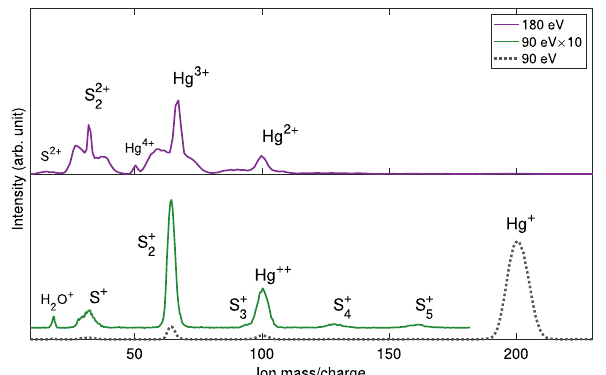
Figure 2. Lower panel: Mass spectra reflecting primarily singly charged ions, which were extracted in coincidence with one electron of a binding energy of 5–20 eV, obtained at the photon energy of 90 eV (dashed grey line and solid green line). The spectrum in dashed grey is dominated by Hg + . The green plot is × 10 magnification of that part of the spectrum which is relevant for the discussion. The full-width-half-maximum + of the S + signal suggests substantial contributions from fragmentation of S 2 2 . Upper panel: a mass spectrum reflecting ions detected in coincidence with two electrons, obtained at the photon energy of 180 eV (solid purple line). At this photon energy, the double ionisation route by Auger decay of the S 2p core holes is